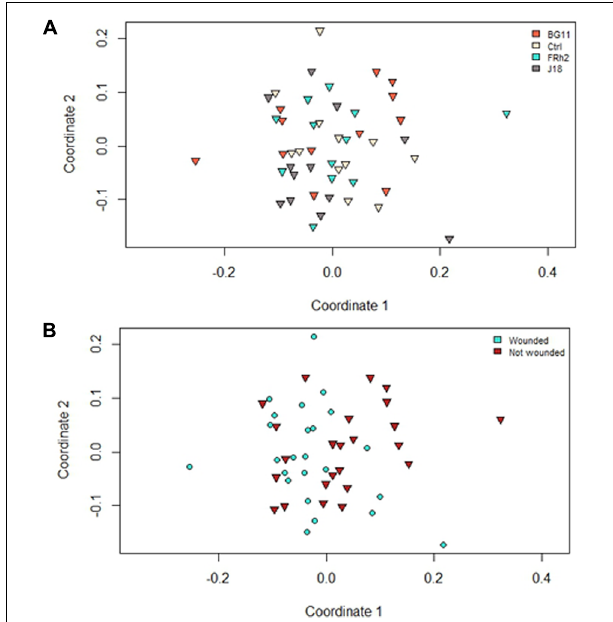
FIGURE 8 | Non-metric multiple dimension scaling plots representing differences between respiration profiles of the microbial communities from rhizosphere soil of Zea mays (maize) sampled 30 days after inoculation (DAI) with Beauveria bassiana . Data are based on distance matrices obtained from MicroRespTM colorimetric readings. Plots are distinguished by either isolate (A) or wound (B) treatments as grouping